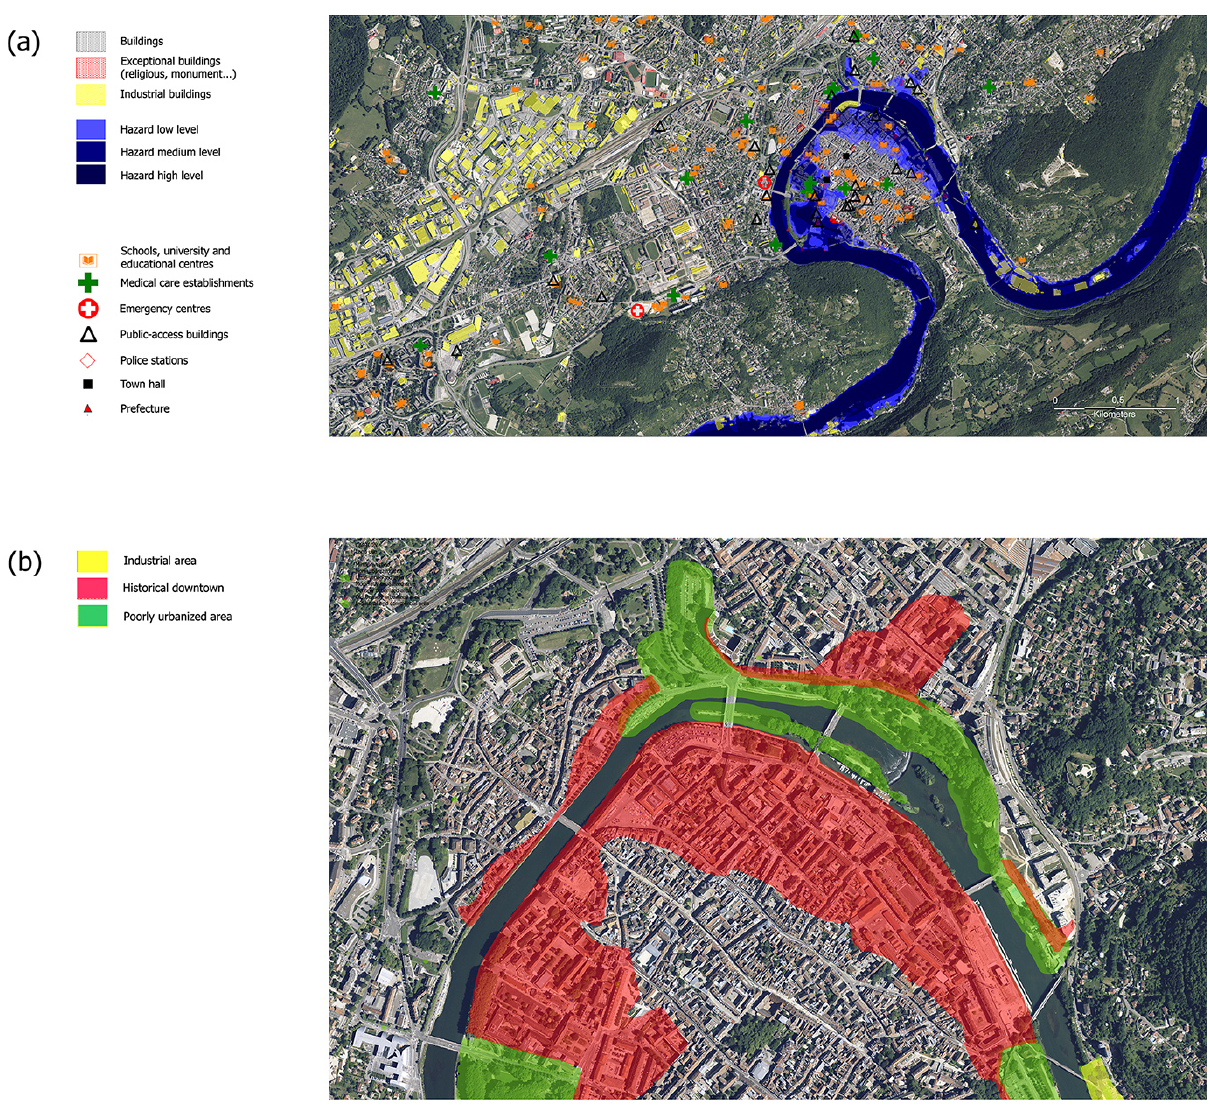
Figure 6. (a) Map of urban components; (b) city center land use in hazard